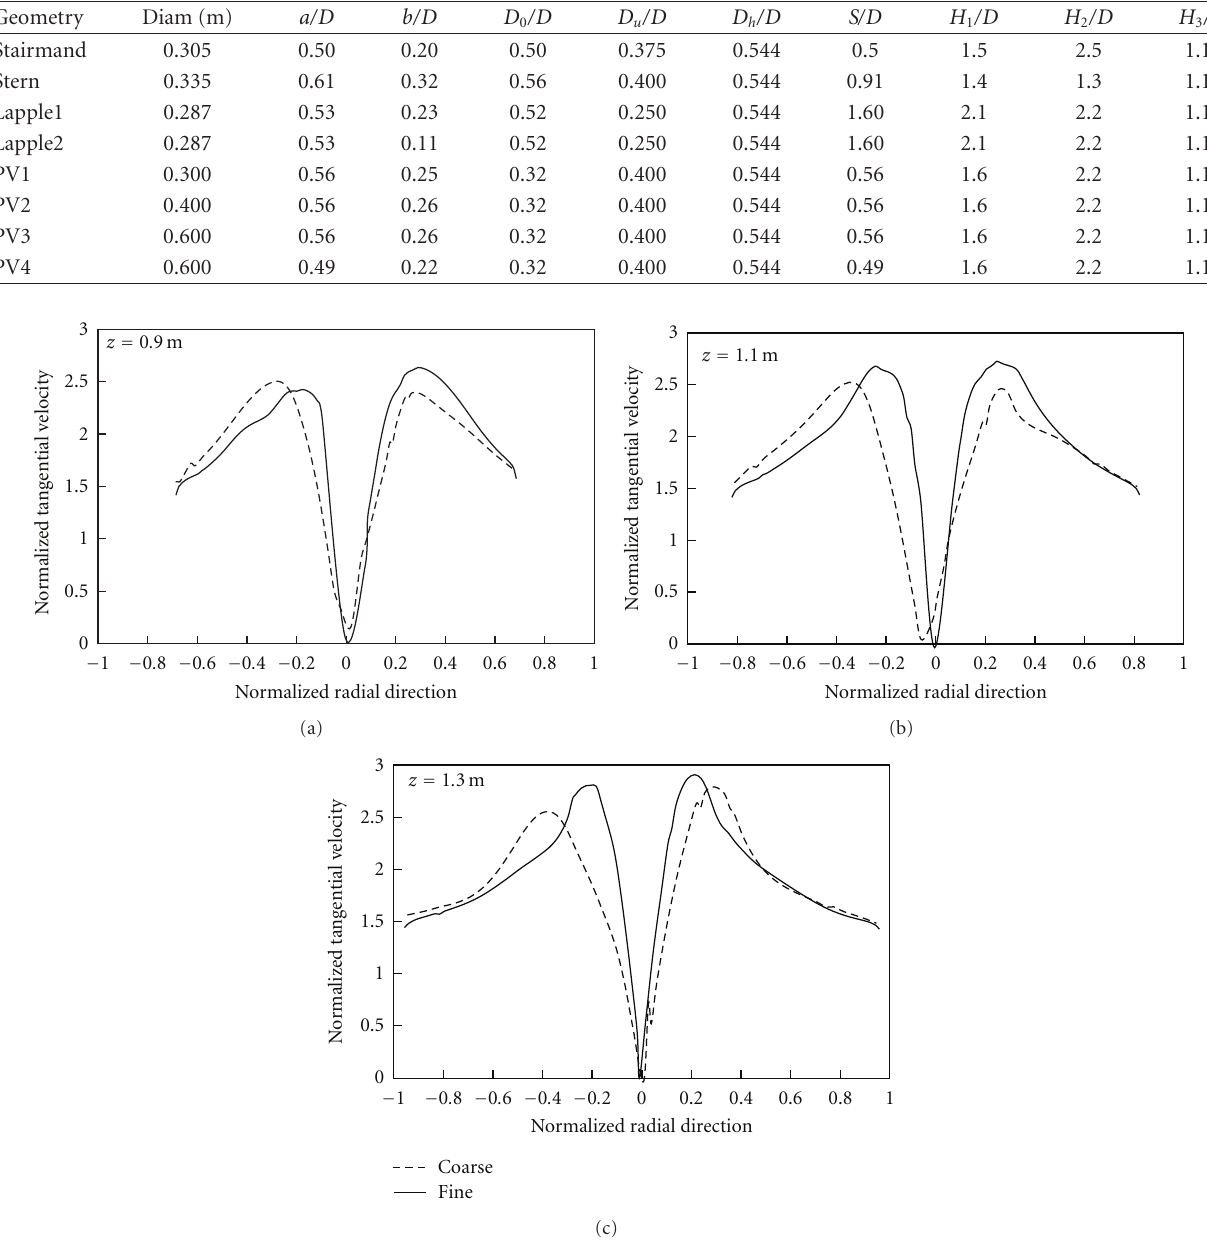
Table 1: Cyclone normalized dimensions.